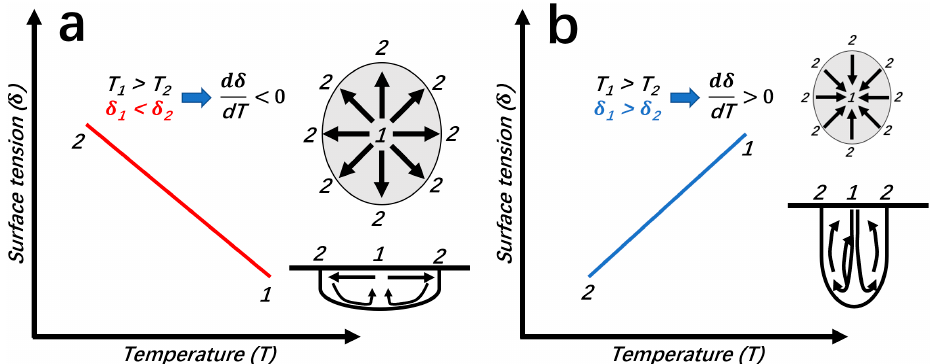
Figure 12. Schematic figure showing Marangoni flow in TIG welding: ( a ) without flux ( b ) with flux (redrawn from [48], © 2021, Lu, Shanping, et al.).